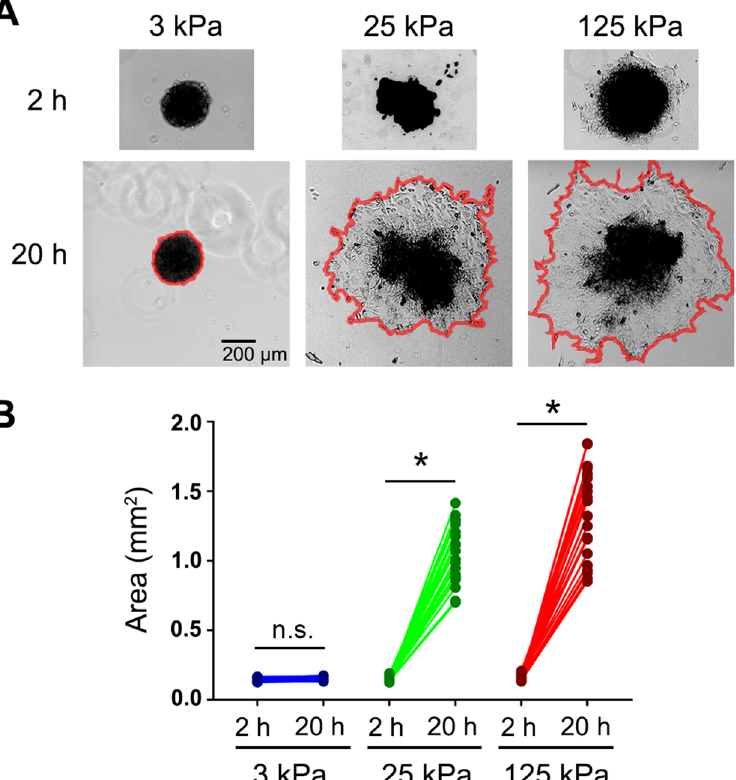
Figure 7. Disaggregation of ovarian cancer spheroids is dependent on substrate rigidity. ( A ) SKOV3 multicellular spheroids were plated on FN-coated hydrogels with rigidities of 3 kPa, 25 kPa, and 125 kPa and imaged at 2 h and 20 h post plating. Red lines in the 20 h panels help visualize the boundaries of the tumor spheroids. ( B ) The graph depicts the change in area of each spheroid measured at 2 h and 20 h by manually outlining spheroids at the indicated time points and calculating the area using ImageJ (n = 24 spheroids for each condition; * p < 0.0001; n.s. = not